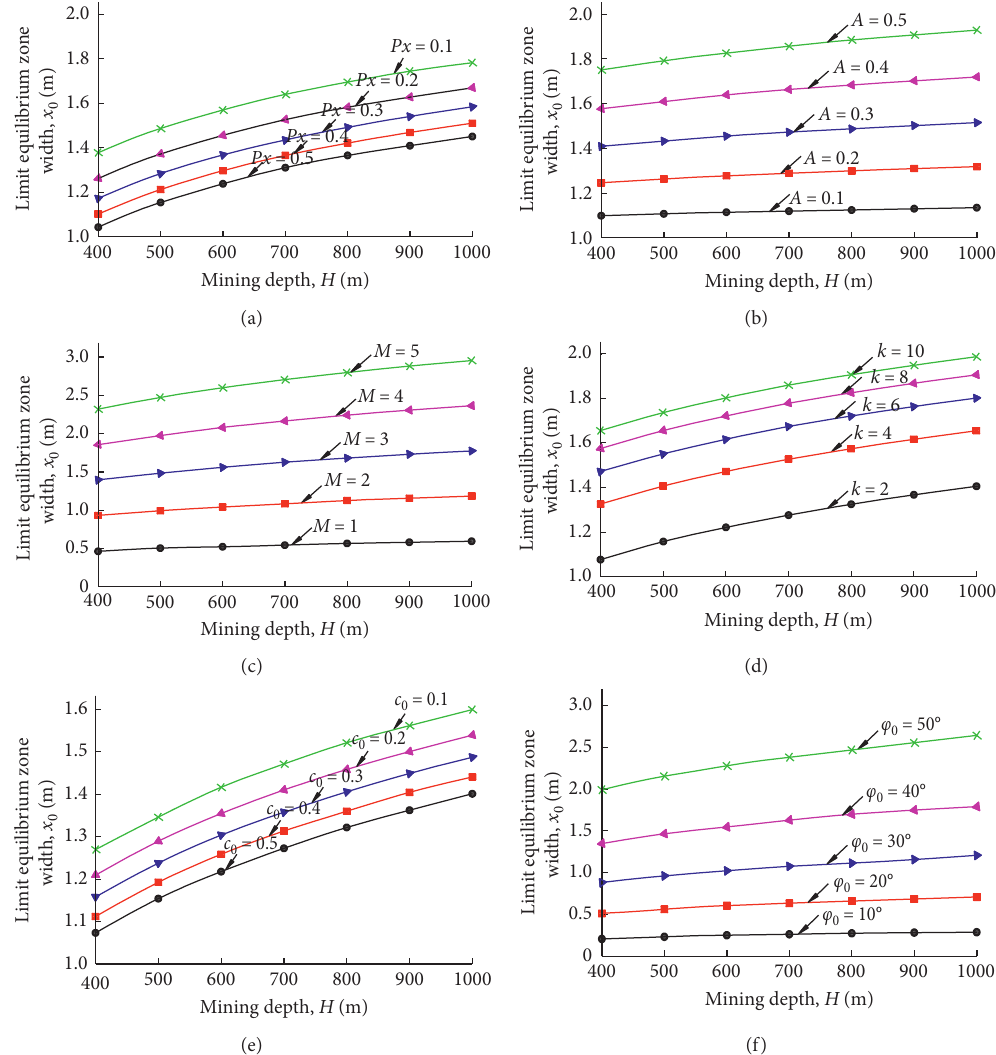
Figure 9: Variation curve of limit equilibrium zone width. (a) x P x , (b) x 0 0 distribution curve with the change of support strength distribution curve with the change of mining height M , (c) x 0 distribution curve with the change of lateral pressure coefficient A , (d) x 0 distribution curve with the change of maximum stress concentration factor ( k ), (e) x 0 distribution curve with the change of coal-rock interface cohesion c 0 , and (f) x 0 distribution curve with the change of internal friction angle of coal-rock interface φ 0